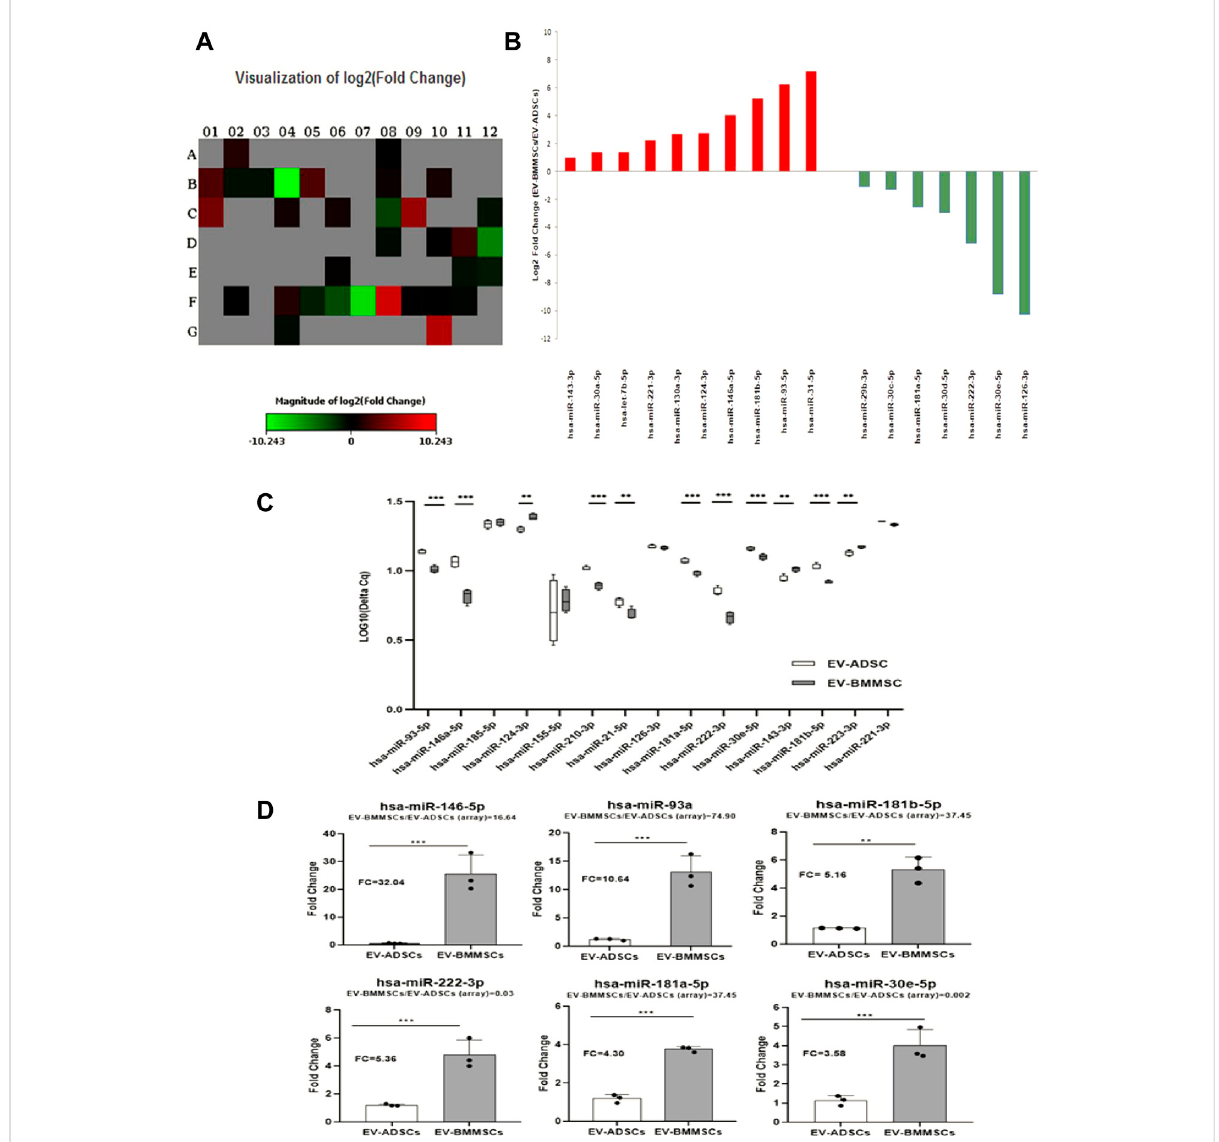
FIGURE 9 Differential expression pro fi ling of miRNAs in EV-ADSCs and EV-BMMSCs. (A,B) miRNA pro fi ling by miScipt miRNA PCR array: (A) Heat-map pro fi leshowingmiRNAexpressionrepresentedaslog2FoldChange,whereFoldChangewascalculatedasnormalizedmiRNAexpression(2- Δ Cq)in EV-BMMSCs divided to the normalized miRNA expression (2- Δ Cq) in EV-ADSCs; (B) Bar plot representing log2 Fold Change of 17 differentially expressed miRNAs, of which 7 miRNAs were down-regulated (green) and 10 up-regulated (red) in EV-BMMSCs relative to EV-ADSCs; (C,D) TaqMan miRNA assays for selected miRNAs in EV-ADSCs and EV-BMMSCs: (C) Data for each selected miRNA are presented as boxplot of log- transformed values of Cq levels from four independent experiments; (D) Fold Change of miRNA expression in EV-BMMSCs relative to EV-ADSCs determined using TaqMan miRNA Assays, with bars represented as the mean ± standard error of the mean of three independent experiments. For comparison, fold change of EV-BMMSCs relative to EV-ADSCs found in miScript miRNA PCR array analyses was given for each miRNA when compared with EV-ADSCs, unpaired t-test analysis) (* p < 0.05, ** p < 0.01, *** p <